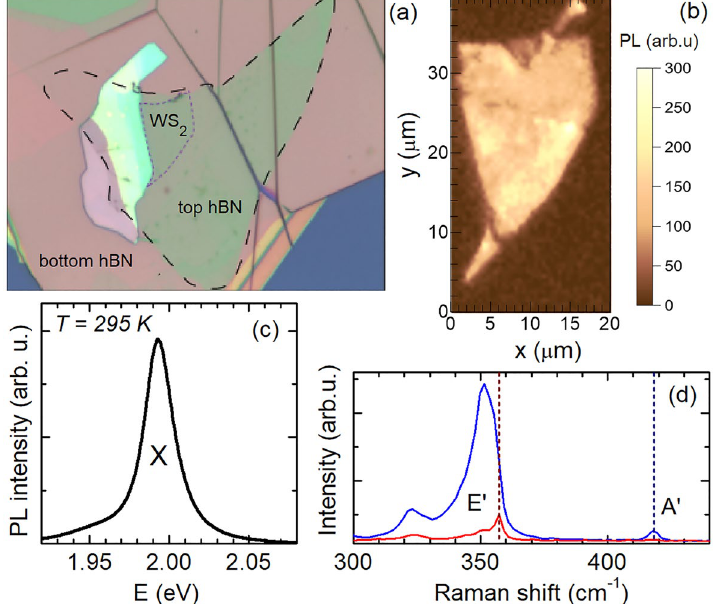
Figure 7. ( a ) Optical microscope contrast image of the hBN/WS 2 /hBN/SiO 2 /Si heterostructure. ( b ) PL intensity map across the WS 2 monolayer studied. ( c ) Exemplary PL spectrum showing the emission of the neutral exciton, E exc = 2.33 eV. ( d ) Room-temperature Raman scattering spectra including the E